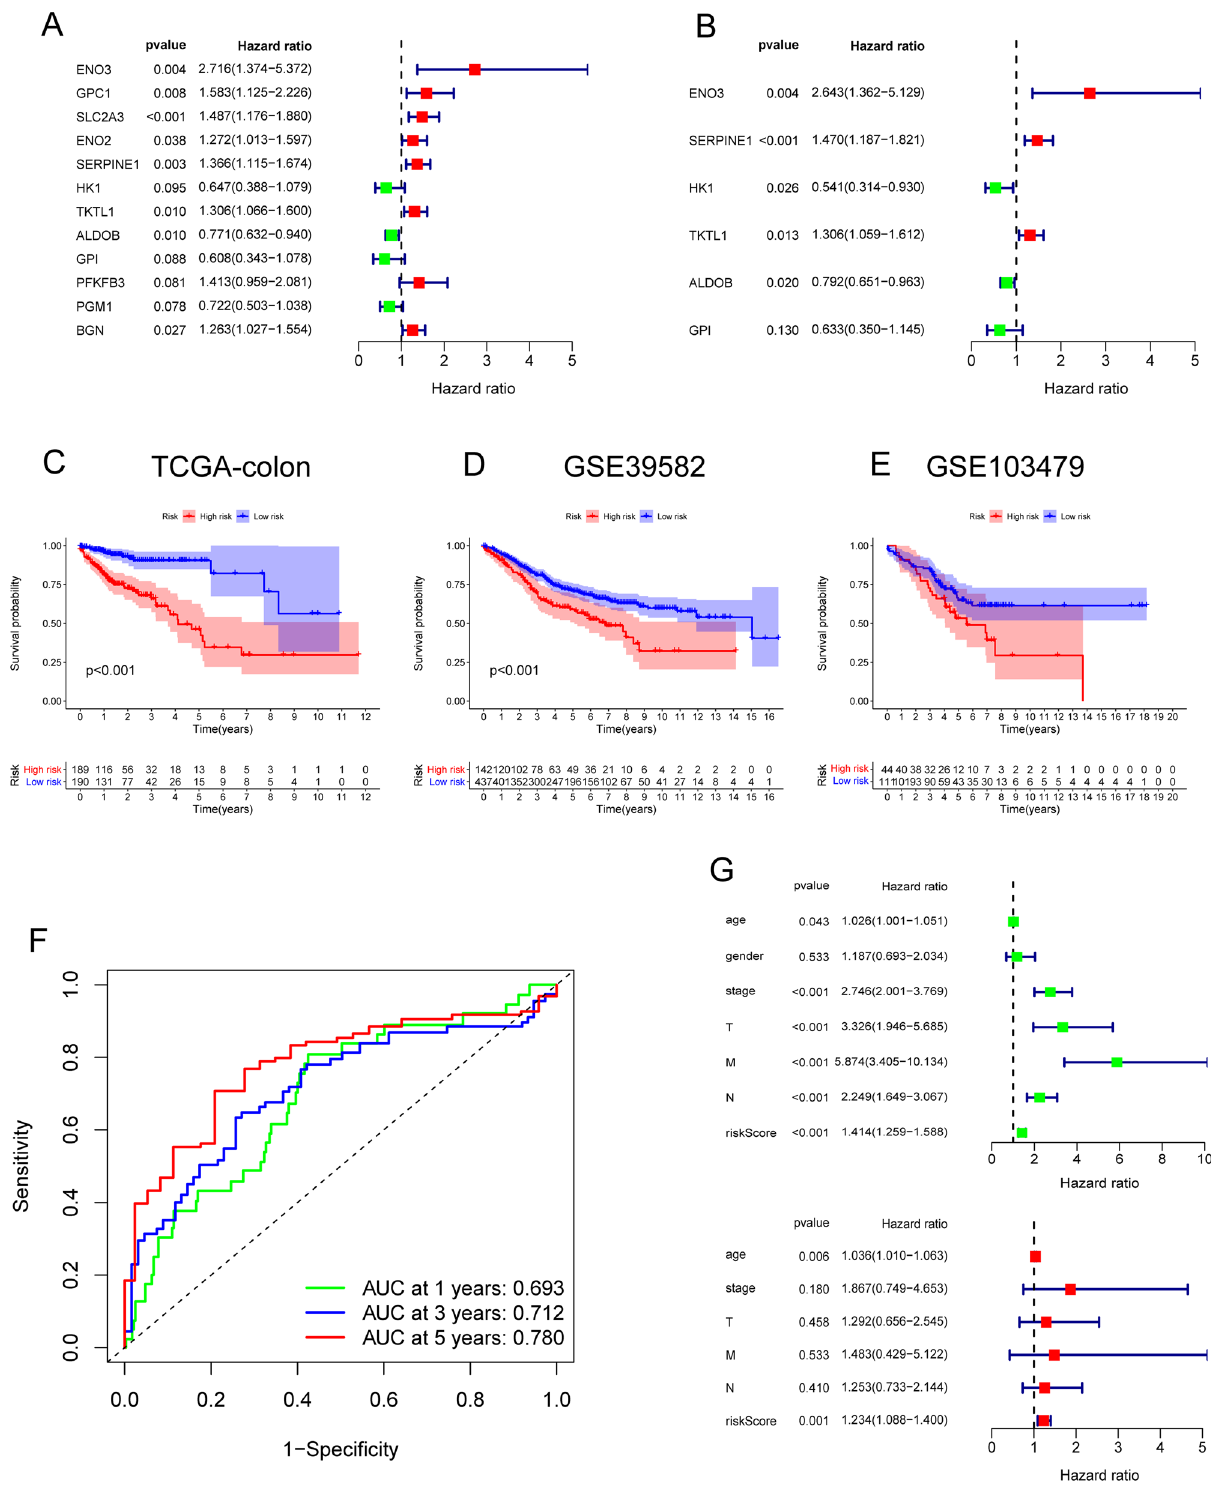
Figure 2. Construction of the prognostic HRG model. ( A ) Differentially expressed HRGs in CRC patients and healthy individuals in the TCGA. ( B ) Multivariate and univariate Cox regression analyses of the prognostic model’s six HRGs. ( C ) K–M curves of OS in the TCGA dataset. ( D ) K–M curves of OS in the GEO dataset. ( E ) ROC curve for the TCGA dataset. ( F ) Multivariate and univariate Cox regression analyses of risk scores and clinicopathological